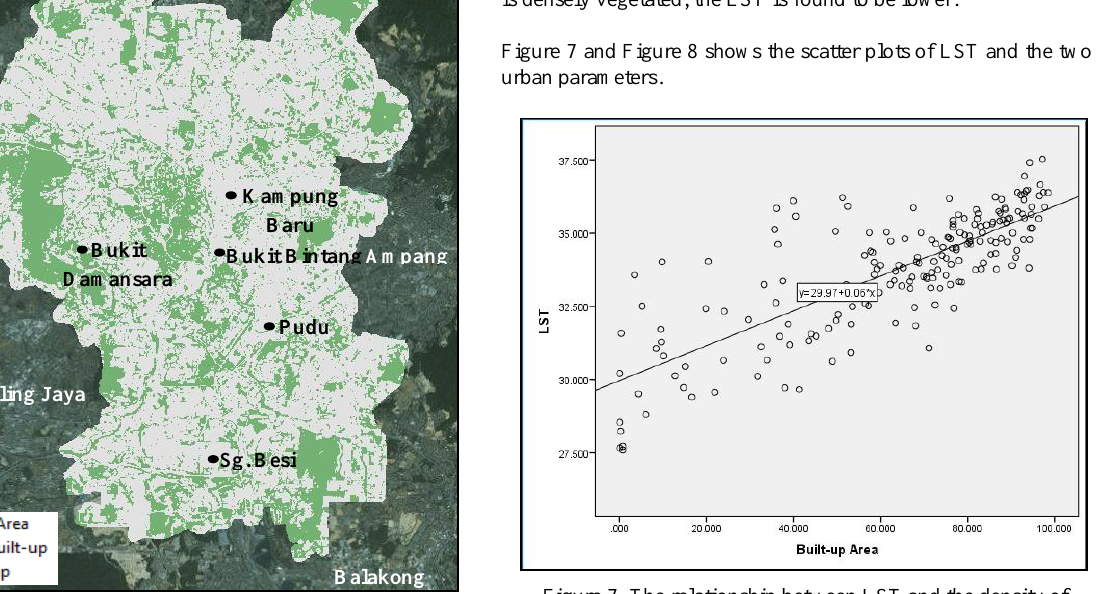
Figure 5. Distribution of the Built-up Areas in Kuala Lumpur.